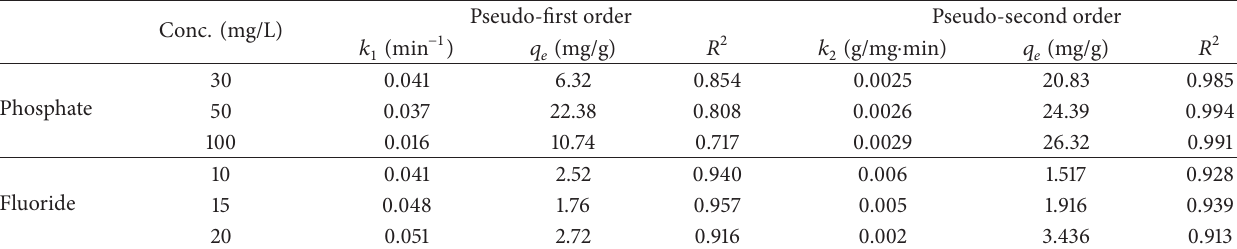
Table 1: The kinetic model parameters for the adsorption of phosphate and fluoride on LDPO. Conc.